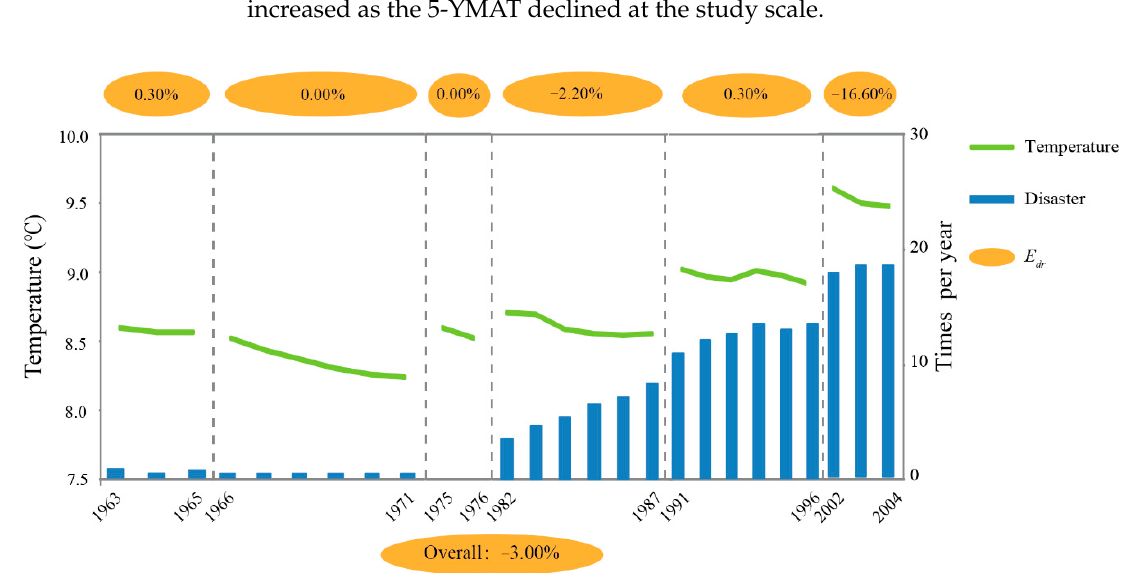
Figure 6. The arc elasticity coefficient ( E dr ) of 5-YMAT and ACND during temperature-drop periods. The coefficient values for each temperature cycle period are shown in the ovals above the figure. The corresponding coefficient for the entire temperature-rise period is shown in the oval below the figure.